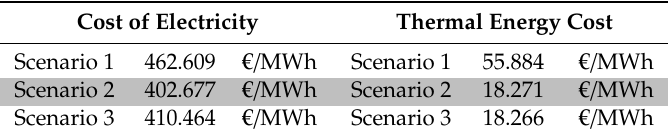
Table A2. Final energy